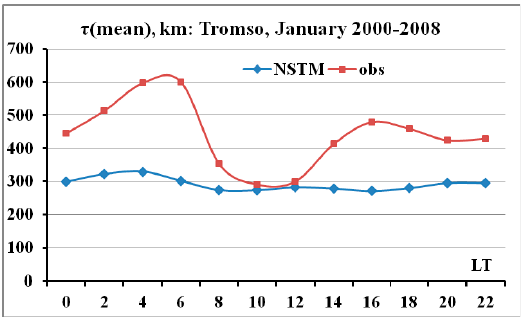
Figure 4. Diurnal variation of the observed and modeled τ over Tromsø for January 2000–2008.